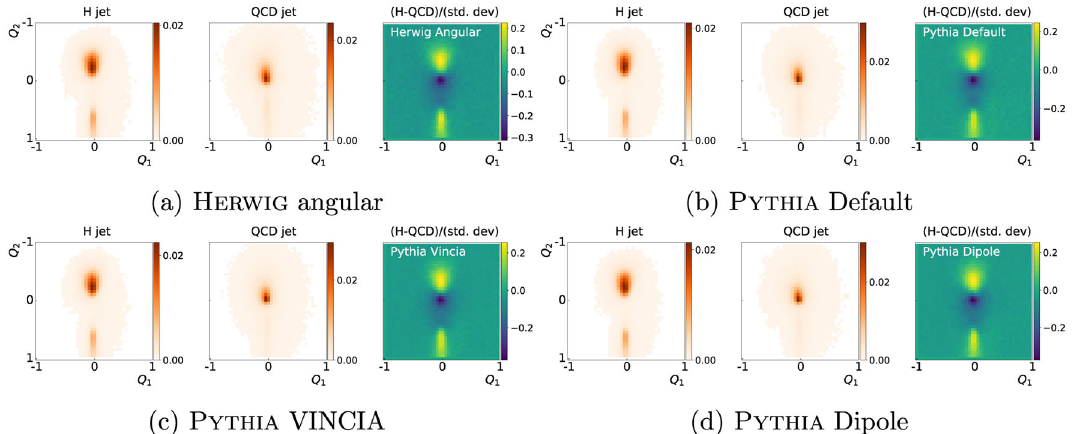
Fig. 2 Low-level features. The average of 40000 Higgs-like jet images in the charged p T channel (left column and middle column). Q 1 and Q 2 denote the new axes after the jet’s axis is centralized and rotated. The